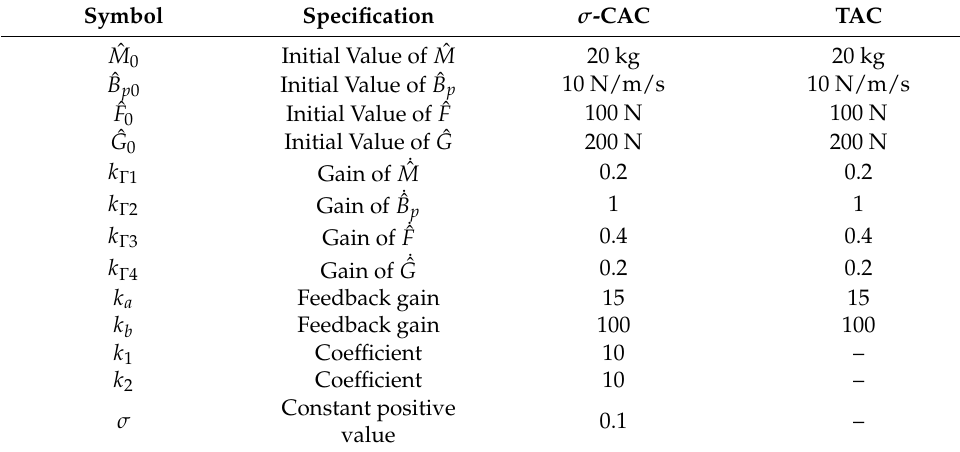
Table 1. Parameters of two